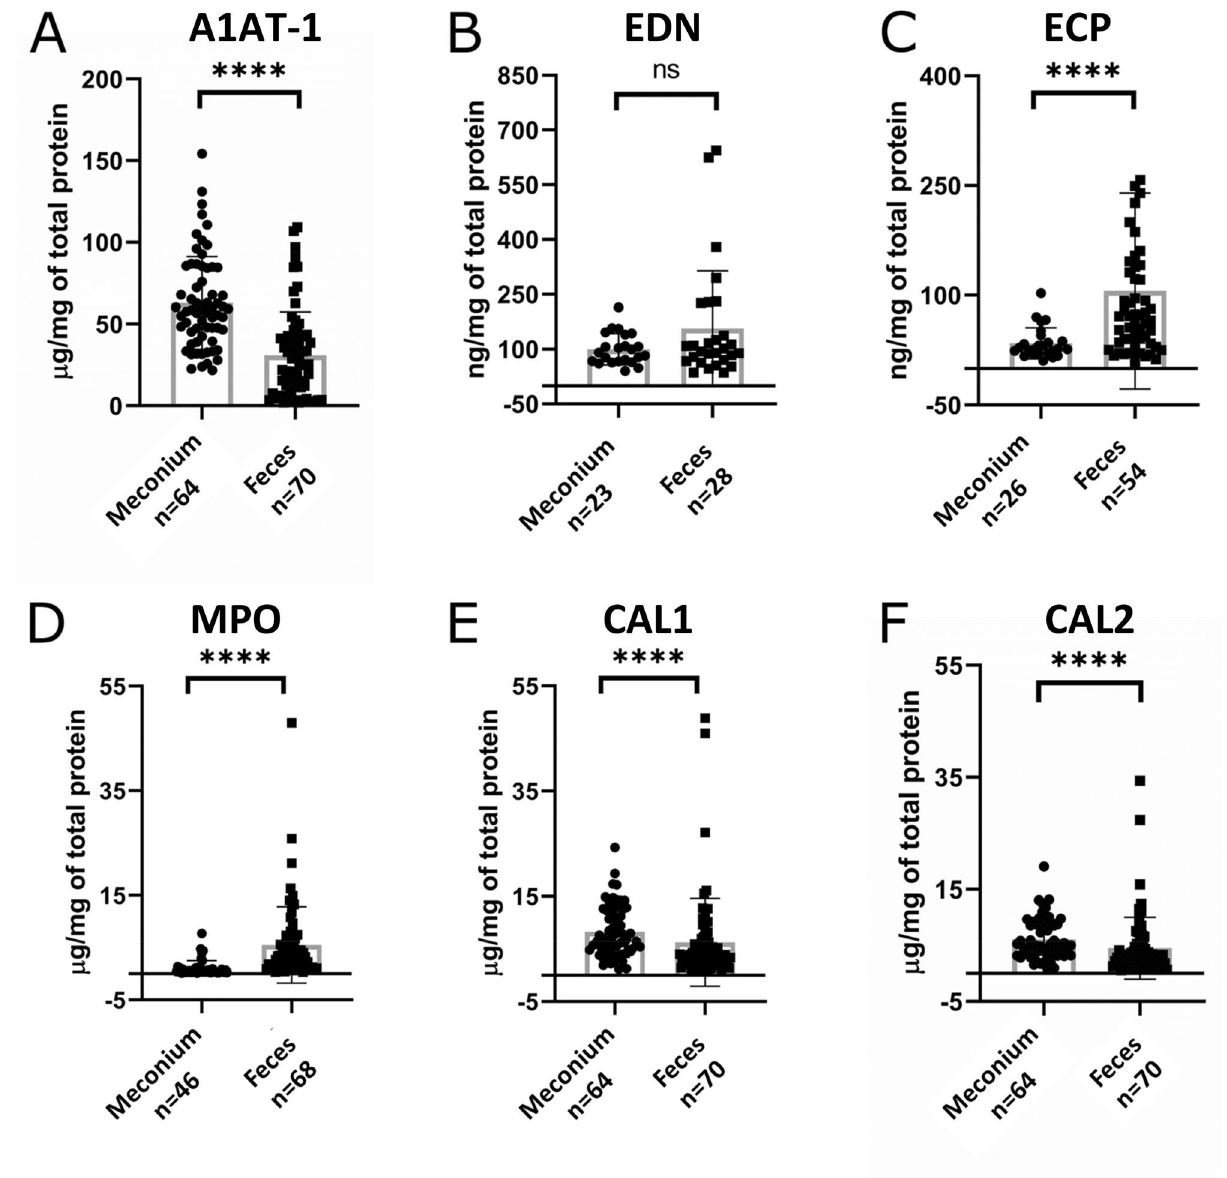
Figure 2. Levels of immune protein markers in meconium and feces: ( A ) A1AT-1, ( B ) EDN, ( C ) ECP, ( D ) MPO, ( E ) CAL1, ( F ) CAL2. Mann–Whitney U test **** P < potential contribution to meconium EDN (Fig. 3). If ECP and EDN in meconium and feces are derived only from eosinophils, the EDN/ECP ratio in meconium and feces is expected similar. The EDN/ECP ratio in meconium was substantially higher than in the first feces suggesting a contribution from other white blood cells to the total meconium EDN level. However, the different EDN/ECP ratios may also reflect changes in eosinophil protein expression after the first day of life. A1AT-1, IGHA1, IGHA2, IGHA1 + 2, ECP, EDN, MPO, CAL1, and CAL2 levels (Table S2) in meconium and feces (n = 134), sorted by decreasing concentration of IGHA were cross-correlated using the Spearman correlation factor (Fig. 4). The excretory IGHA1 + 2 in feces and meconium negatively correlated with A1AT-1 (Spearman correlation factor of − 0.6), as previously reported 32 . Li et al. demonstrated decreasing calprotectin levels in neo- natal stool between 1 to 18 months 45 . Indeed, we detected a negative correlation of IGHA1 + 2 with both CAL1 and CAL2 (Spearman correlation factor of − 0.4). MPO and ECP moderately correlate with IGHA1 + 2 (Spearman correlation factor of 0.67 and 0.59, respectively). MPO was associated with ECP (Spearman correlation factor of 0.72) and ECP with EDN (Spearman correlation factor of 0.63). Birth mode influence on immune protein levels in meconium and feces. Meconium and feces samples were from neonates delivered vaginally (VD) and via cesarean section (CS). VD reportedly fosters the